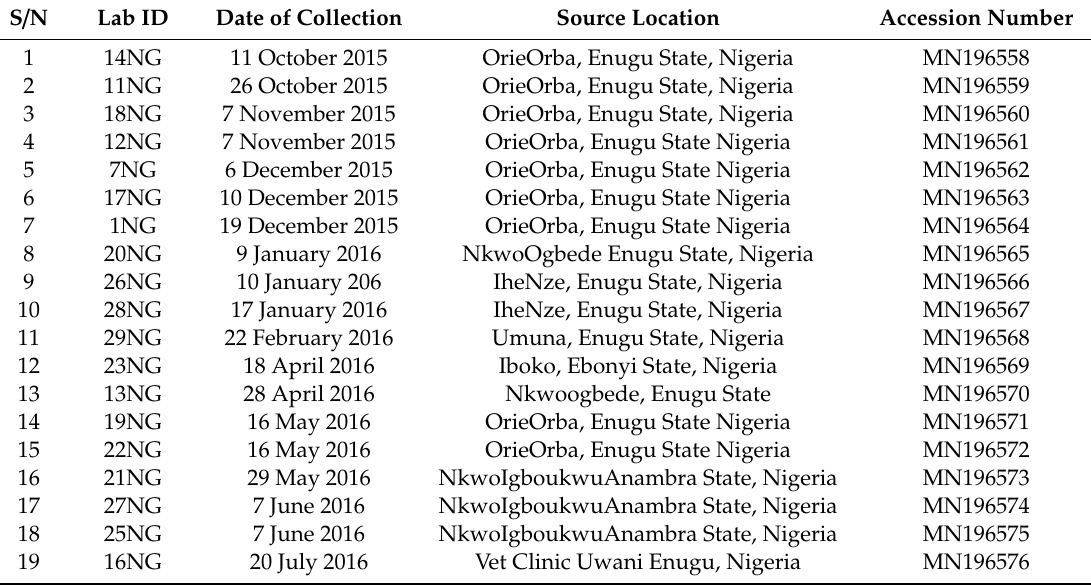
Table 3. Rabies specimens collected from brain tissues of dogs ( Canisfamiliaris ) in Southeastern Nigeria for molecular and phylogenetic